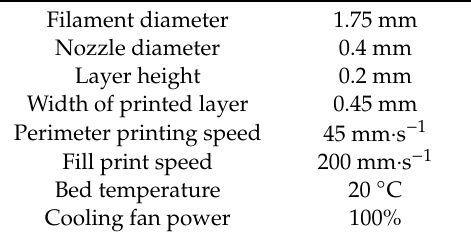
Table 2. Basic printing parameters of used 3D